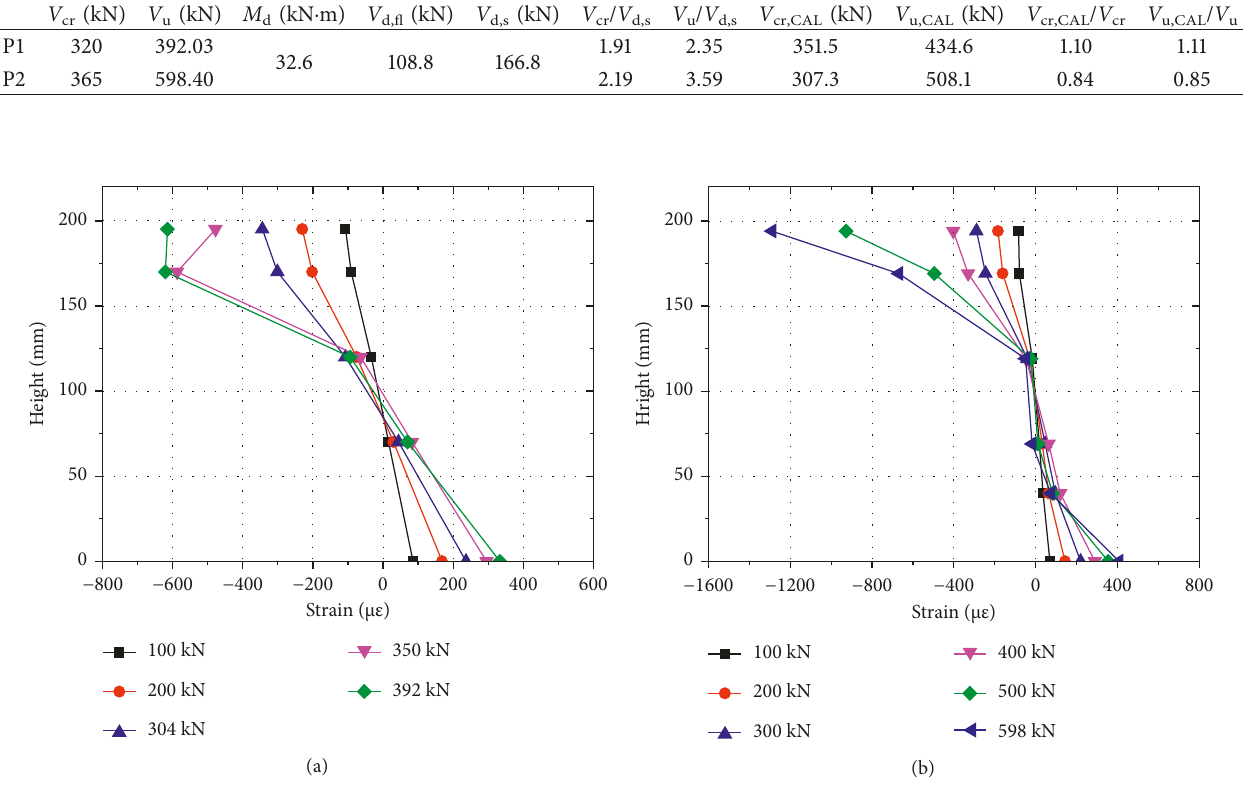
Figure 16: Longitudinal strain distribution along the height at Section C. (a) P1. (b) P2.